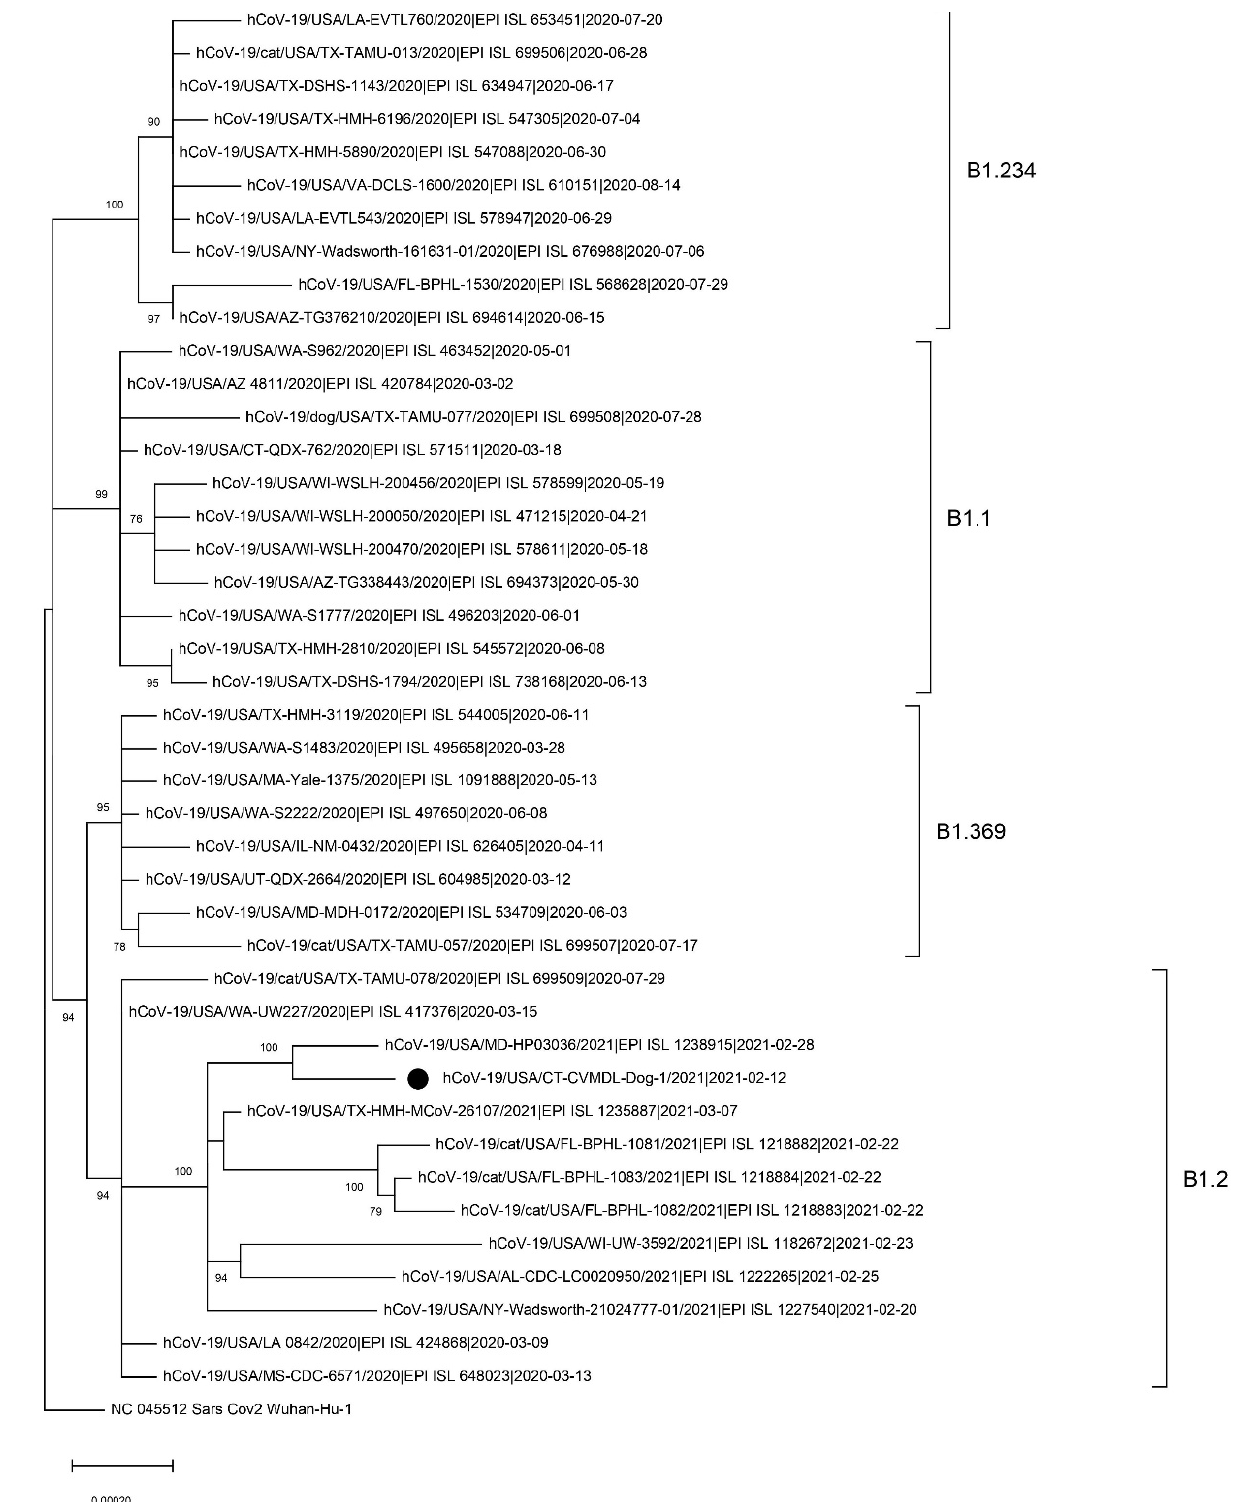
Figure 2. Maximum-likelihood phylogenetic tree of the full-length SARS-CoV-2 genome sequences. The tree was rooted to the Wuhan-Hu-1 virus. Bootstrap values over 70% are shown next to the branches. Scale bar indicates nucleotide substitutions per site. The black circle identifies the hCoV-19/USA/CT-CVMDL-Dog-1/2021 (CT_Dog/2021) virus. The genetic lineages assigned using the PANGOLIN v2.0 (https://github.com/hCoV-2019/pangolin, accessed on 10 March 2021) are indicated with brackets.